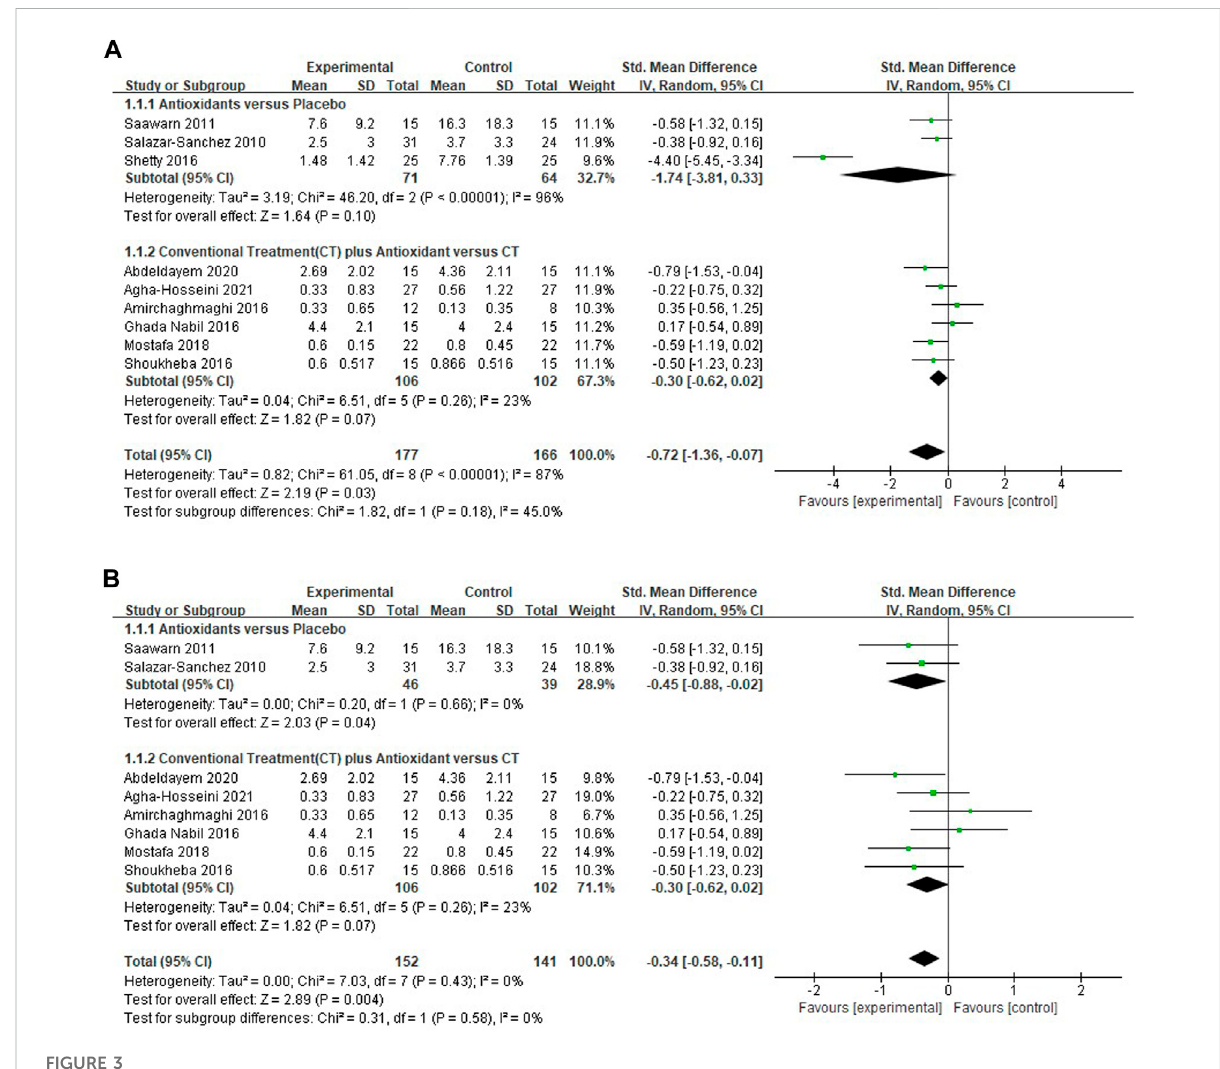
FIGURE 3 (A) Forest plot of pain score. (B) Forest plot of pain